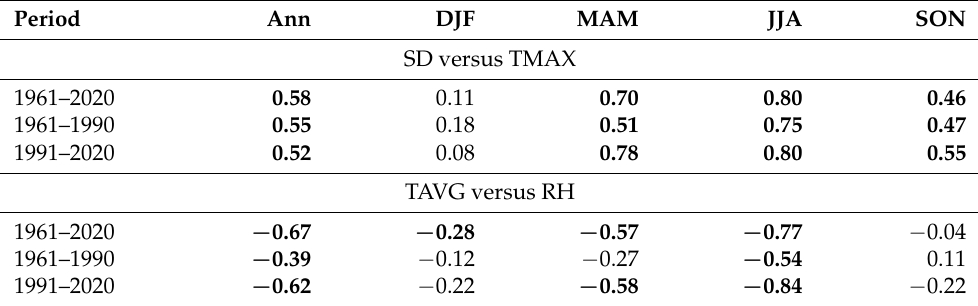
Table 9. Pearson correlation coefficients of annual (Ann) and seasonal (DJF, MAM, JJA, and SON) series between sunshine duration (SD) and mean maximum temperatures (TMAX) and between mean air temperature (TAVG) and relative humidity (RH) in the CR during the 1961–2020, 1991–1990, and 1991–2020 periods. Statistically significant correlation coefficients at the 0.05 significance level are in